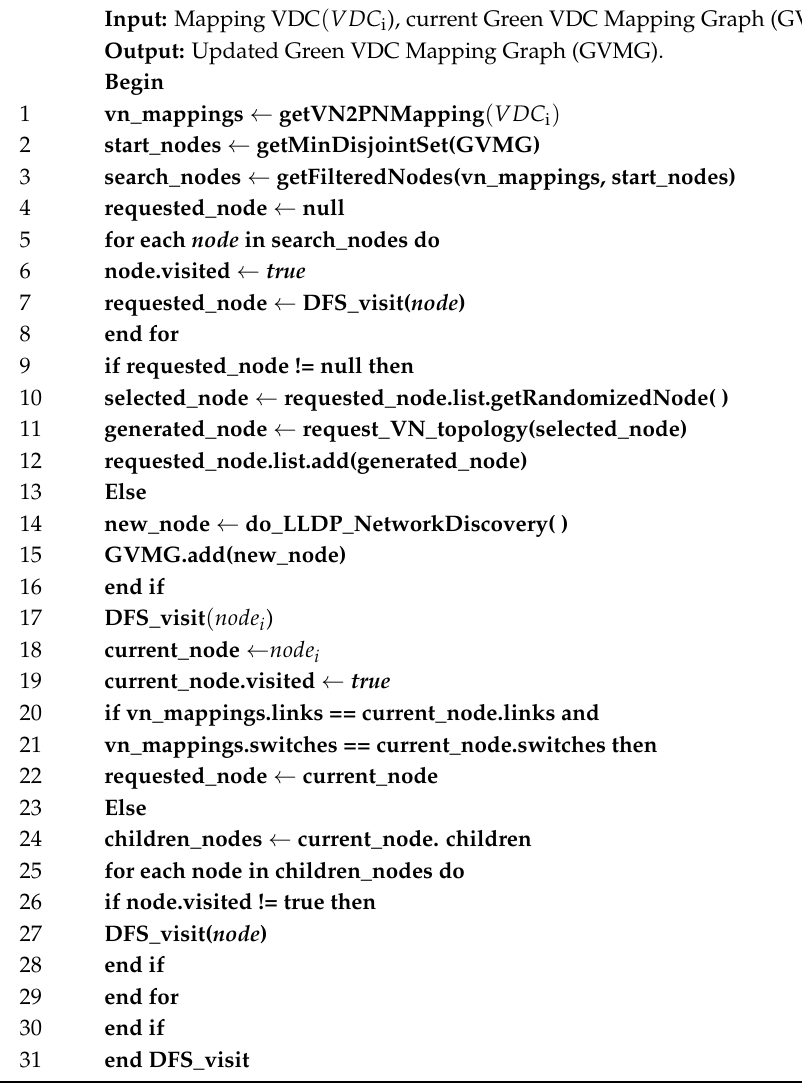
Algorithm 1: VN_Topology_Request ( VDC i